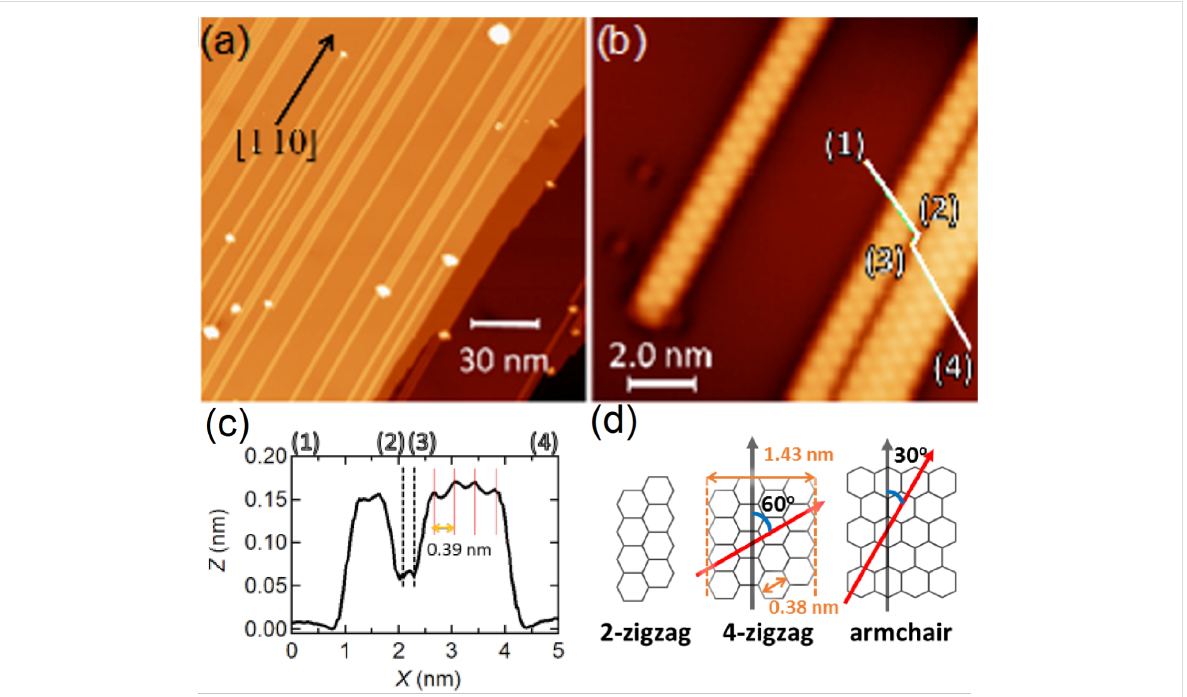
Figure 1: STM images of SiNRs on Ag(110) with (a) V S = − 500 mV, I t = 10 pA and (b) V S = − 100 mV, I t = 30 pA. (c) Cross-sectional height profile along the (1)–(4) line shown in (b). (d) Schematic structural models of SiNR structures. The black arrows dictate the longitudinal direction and the red arrows represent the row of the honeycomb units across the